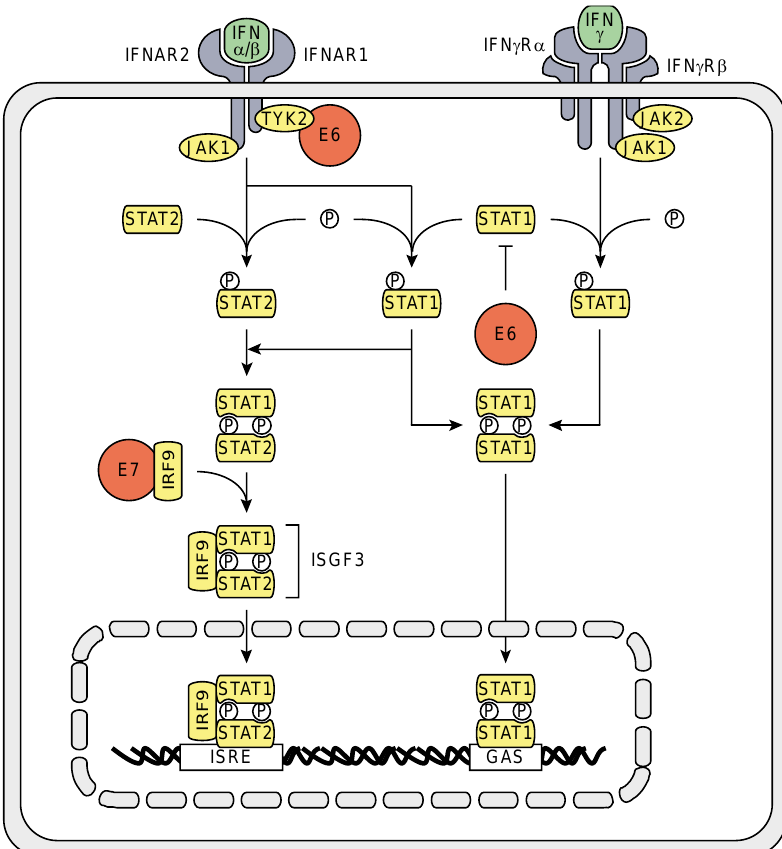
Figure 2. Schematic representation of the effects of hrHPV on IFNAR and IFN γ R signaling. Type I IFN binding to the IFNAR leads to signaling via JAK1 and TYK2 to activate STAT1 and STAT2. STAT1 and STAT2 heterodimerize and recruit IRF9, forming the ISGF3 complex, which translocates to the nucleus, binds to ISREs and initiates ISG transcription. Activated STAT1 can also homodimerize, translocate to the nucleus, bind to GAS and initiate ISG transcription. Type II IFN binding to the IFN γ R results in the activation of JAK1 and JAK2 and recruitment and phosphorylation of STAT1, which homo-dimerizes, translocates to the nucleus, binds to GAS on the DNA and initiates ISG transcription. HPV proteins (red) interfere with both IFNAR and IFN γ R signaling by decreasing STAT1 levels, and hampering TYK2 and IRF9.